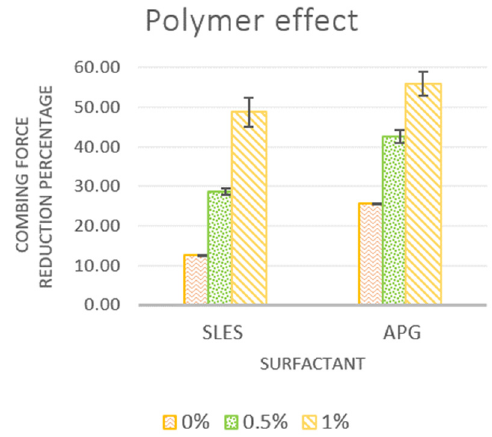
Figure 9. Wet combing reduction percentage for samples with different levels of cationic polymer formulated with both SLES/CAPB and APG/CAPB at 12 wt. % at room temperature and pH ~7.